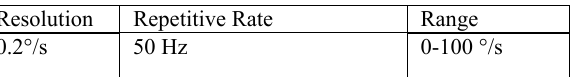
Yaw rate sensor (Tab.3): Used in vehicles with ESP to measure the circular motion of the vehicle around its yaw axis.